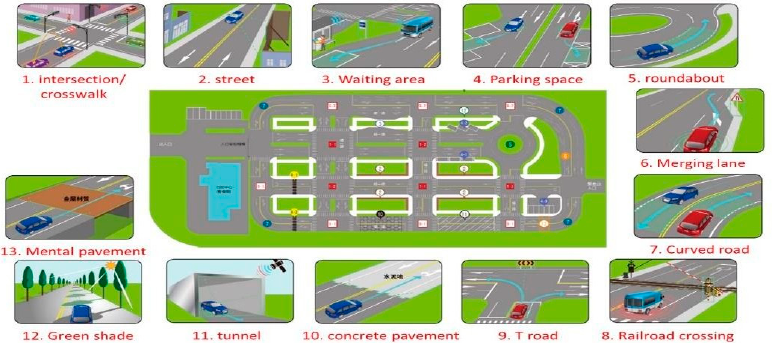
Figure 7. Thirteen scenarios at the Taiwan CAR Lab (https://www.carture.com.tw/topic/article/5663 (accessed on 1 April 2022)).